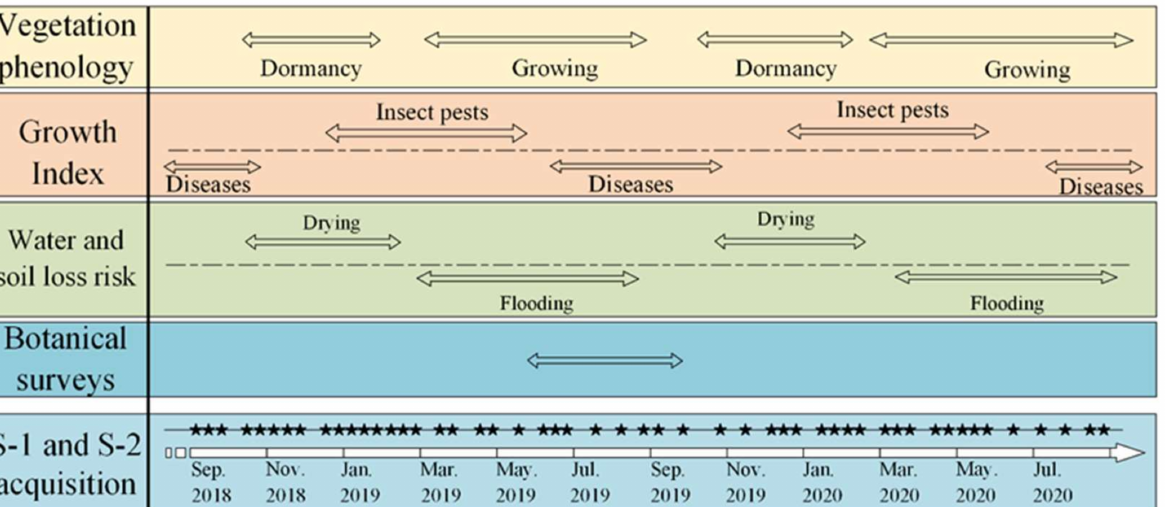
Figure 11. The time-series of S-1 and S-2 imagery acquisition dates about vegetation phenology, growth index, water and soil loss risk and dates of botanical surveys in subtropical evergreen- deciduous broad-leaved mixed forest. Vegetation phenology includes the two periods of vegetation growth (Mar.–Sep.) and dormancy (Oct.–Feb.). The growth index includes the period in insect pests (Jan.–May) and plant diseases (Jun.–Nov.). Water and soil loss risk includes the period in drought (Oct.–Mar.) and floods (May–Aug.). Black stars indicate image acquisition